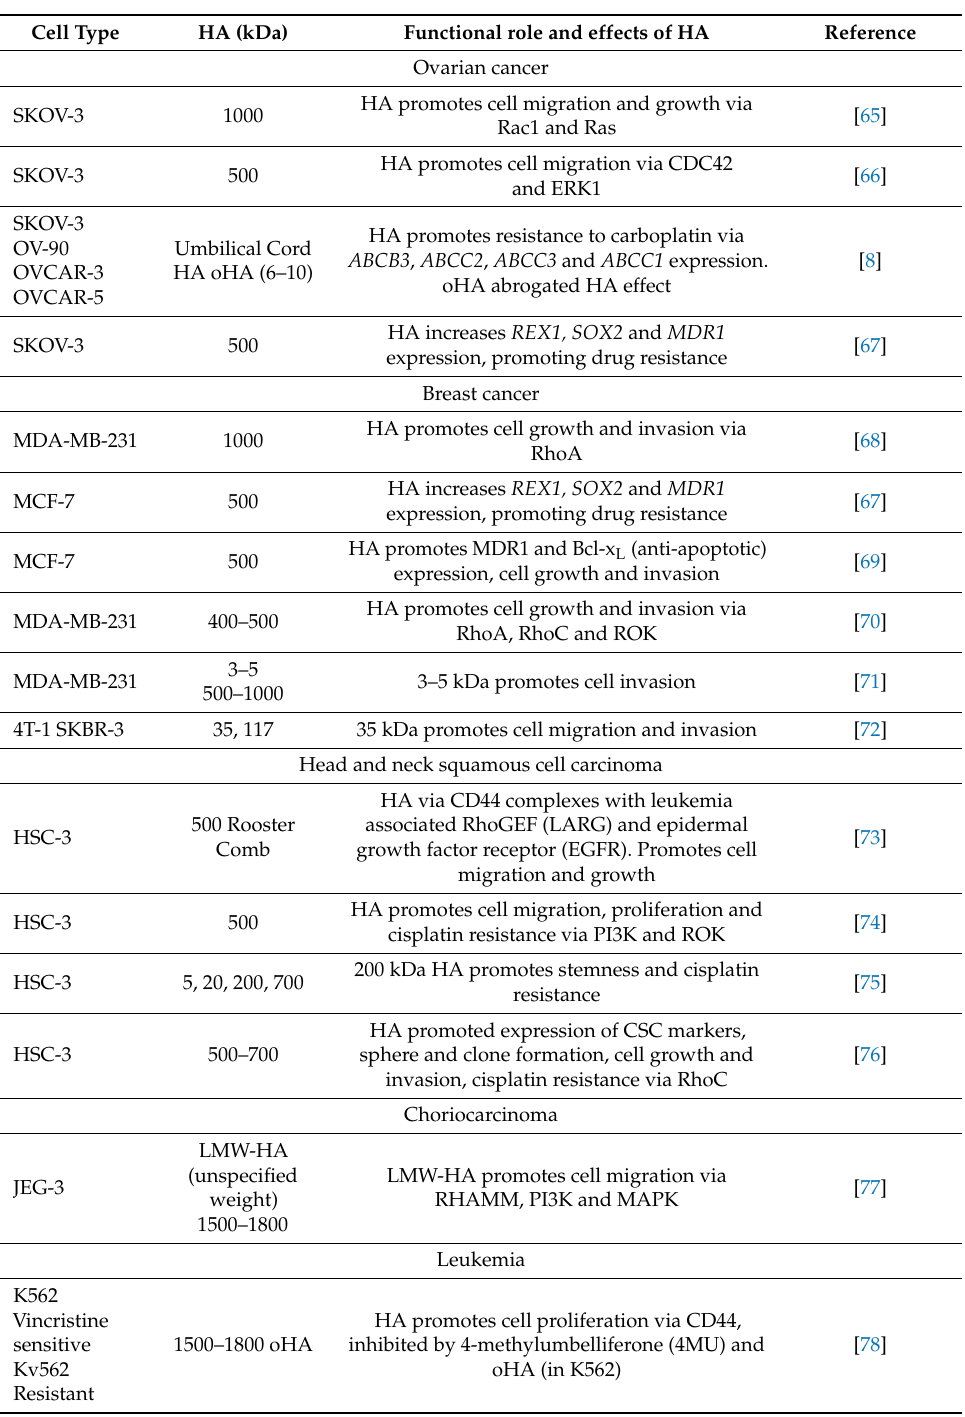
Table 2. Range of studies analyzing effects of exogenous HA of known molecular weights on cancer